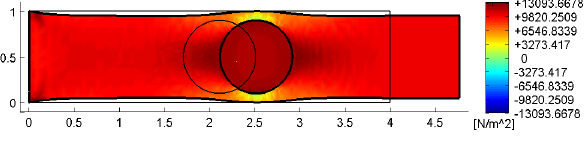
Figure 15: Normal stresses σ x plotted on the deformed configuration (thin line: undeformed configuration; thick line: deformed configu- ration, amplification factor of the displacements: k = 500 ).